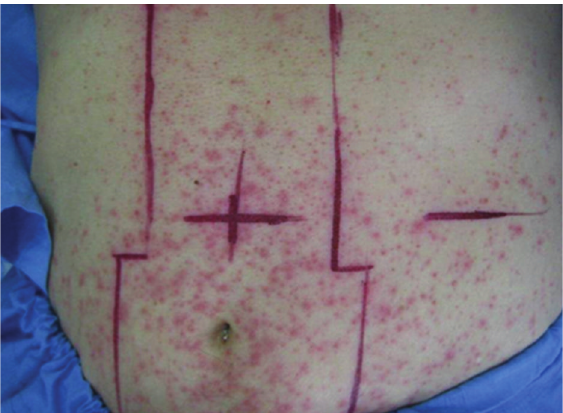
Figure 5: Papulopustules on irradiated area. A 65-year-old-man with non-small-cell lung cancer stage IV and cauda equina syn- drome was admitted for radiation. Erlotinib was given 7 days ago. After 2 days of radiotherapy he developed papulopustular eruption predominantly on the irradiation